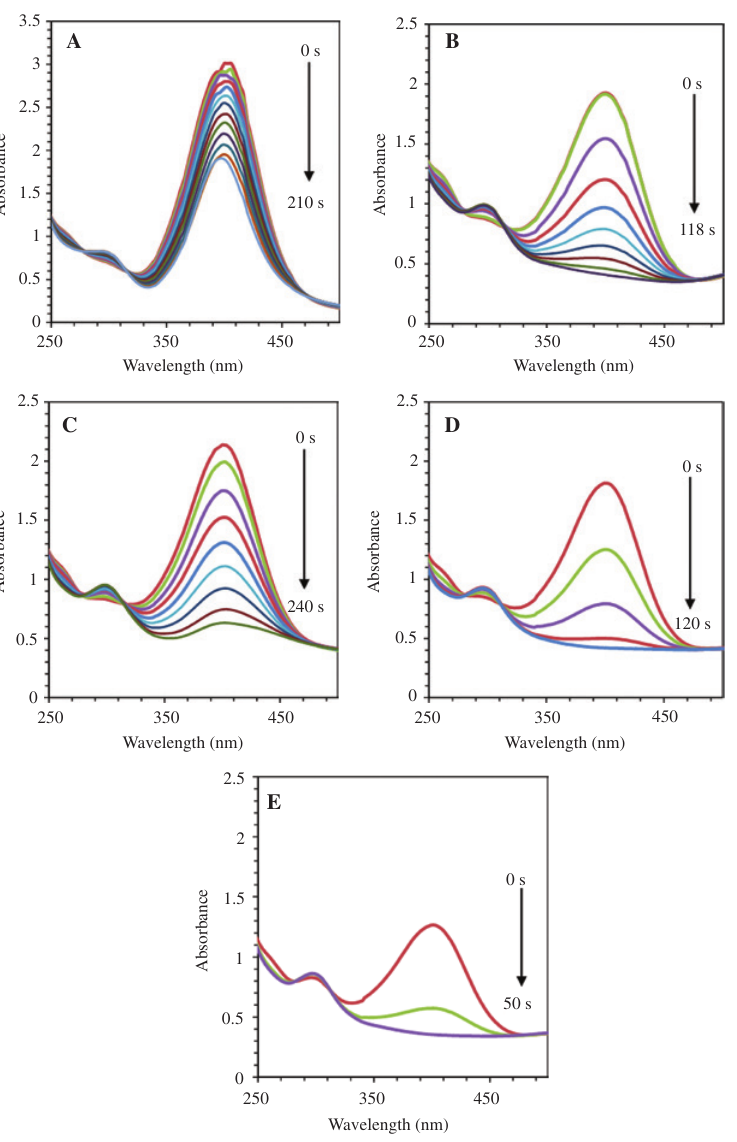
) with (A) Ag, (B) Au, 4